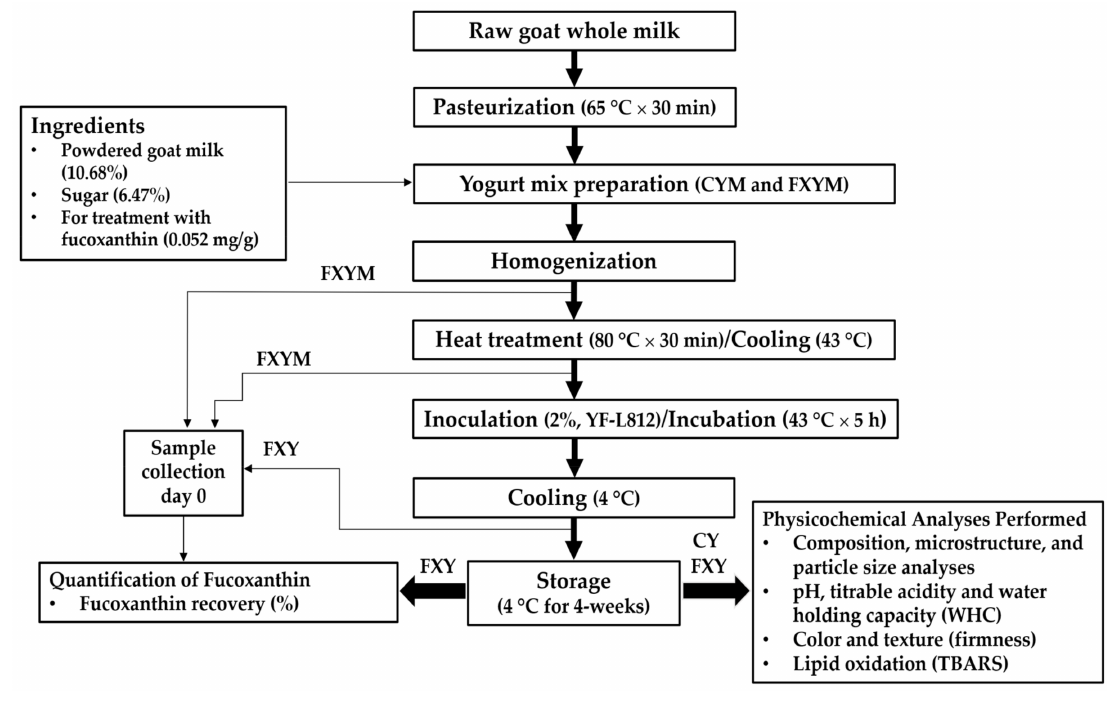
Figure 1. Processing and physicochemical analyses of goat milk yogurt. CYM = Control yogurt mix; FXYM = Fucoxanthin yogurt mix; CY = Control yogurt; FXY = Fucoxanthin